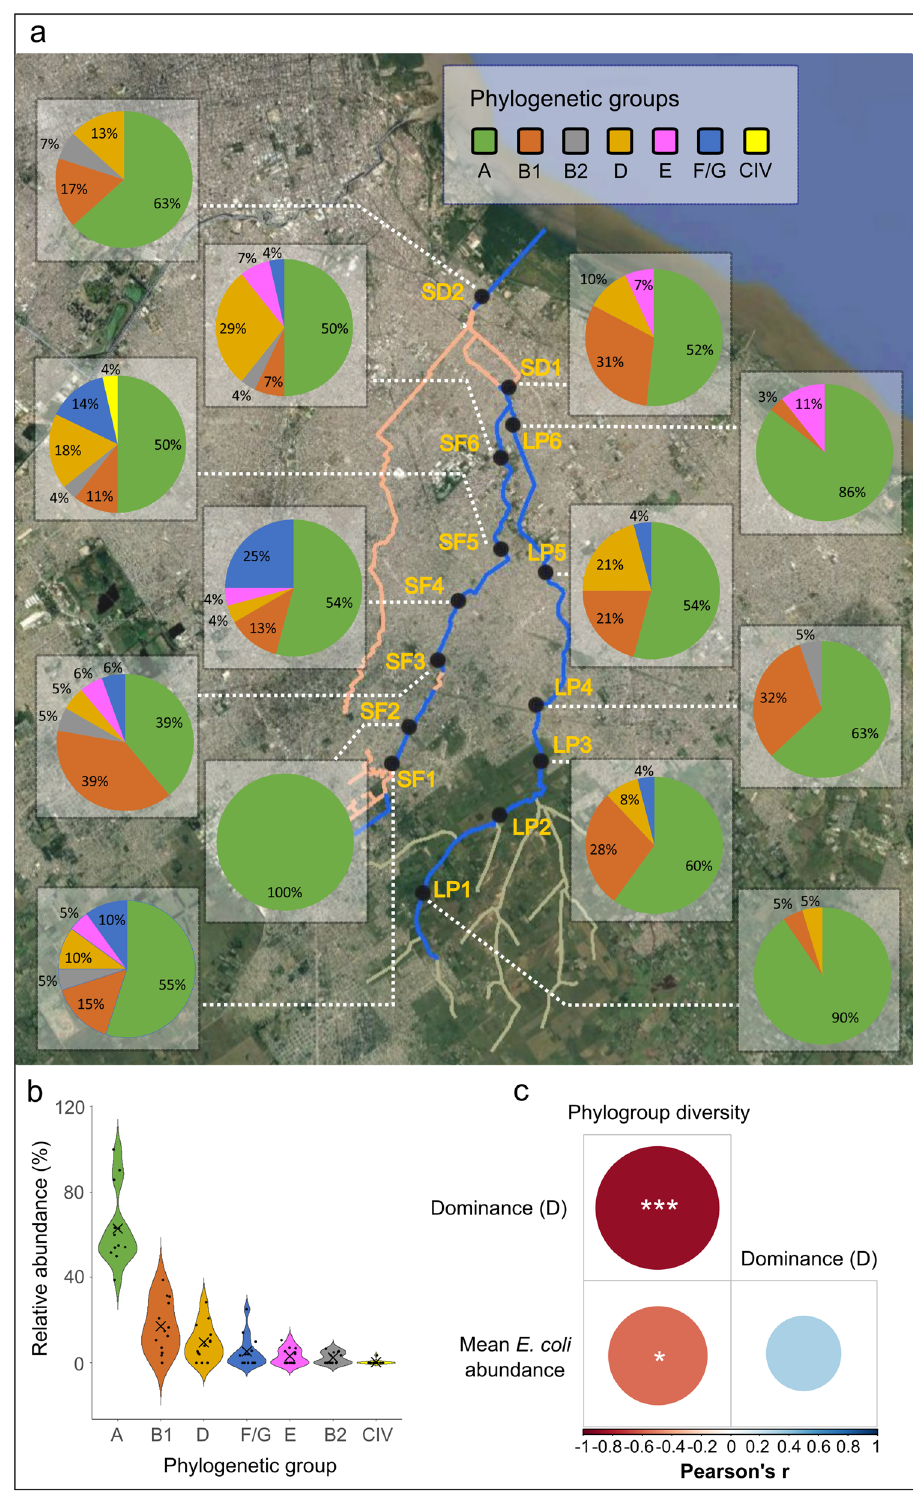
Figure 3. Differences in phylogroup composition of E. coli among locations. ( a ) Spatial distribution of the phylogenetic composition in the sampled locations; pie charts indicating the relative frequency of the phylogenetic groups; ( b ) Violin plot of the relative abundance of the phylogenetic groups. Filled dots represent the relative abundance at each site; crosses indicate the means; ( c ) Correlogram of Pearson’s correlations between Simpson’s dominance index (D), diversity of E. coli phylogroups, and mean E. coli abundance. Significance levels of Pearson’s correlation: * p < 0.05, ** p < 0.001. Base map created in Google Earth V 7.3.3.7786. (October 5, 2020). Buenos Aires Metropolitan Area, Argentina. 34°46 ʹ 47.32 ʺ S, 58°19 ʹ 27.95 ʺ O, Eye